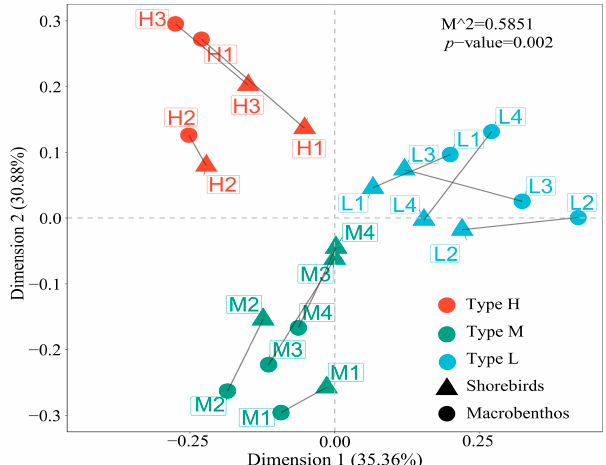
Figure 5. Procrustes analysis of the correlation between macrobenthic and shorebird communities (M 2 = 0.585, p < 0.01, 999 permutations). H1–H3, M1–M4, and l1–l4 indicate the survey locations in the Euryale ferox artificial planting area (type H), the Trapa spp. natural growth area (type M), and the control area (type L), respectively.